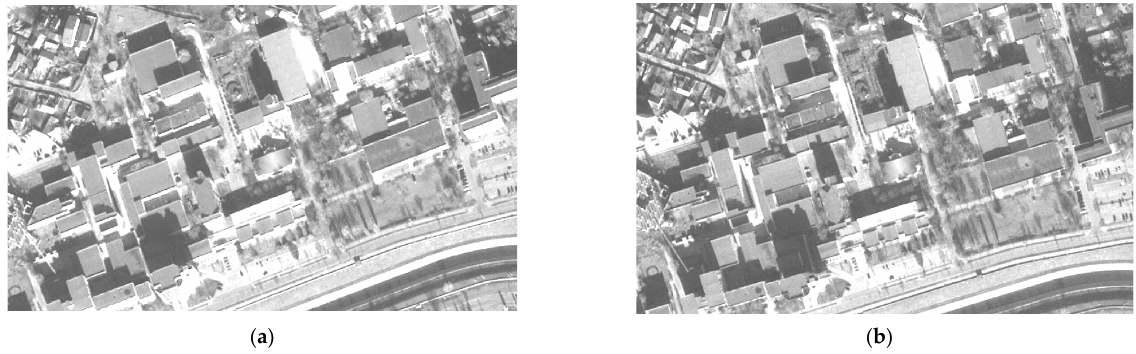
Figure 5. Detail of Pléiades satellite images in panchromatic band on the same area: ( a ) forward- looking image, ( b ) backward-looking image.